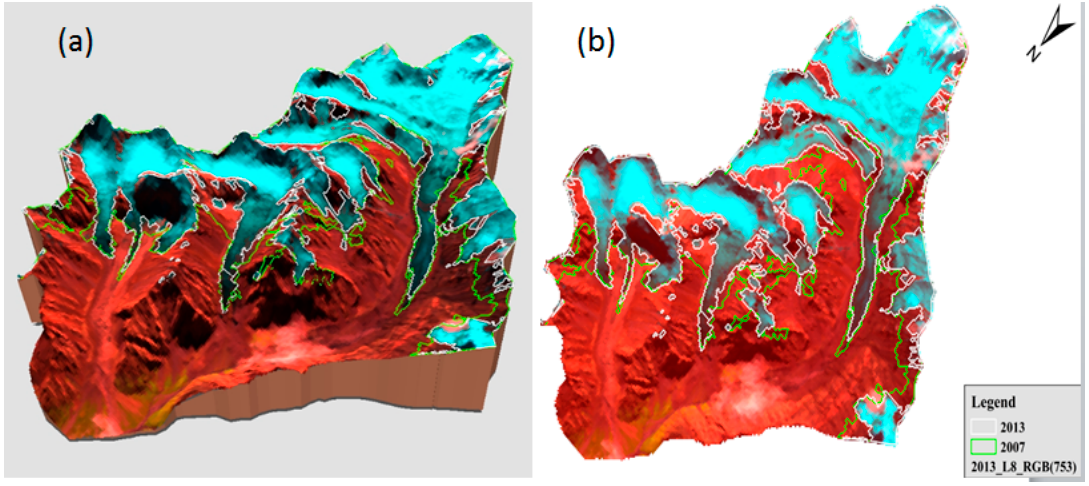
Figure 9. Comparison of 3D ( a ) and 2D ( b ) glacier outlines in 2007 (green lines) and 2013 (white lines) in a glacier sub-catchment of the Muzart Glacier catchment (mid-west). The background image is the Landsat 8 on 10 September 2013.